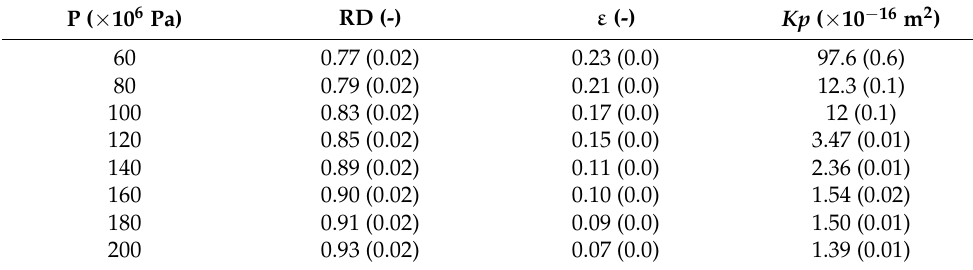
Error at 68.2% of confidence interval (in brackets).